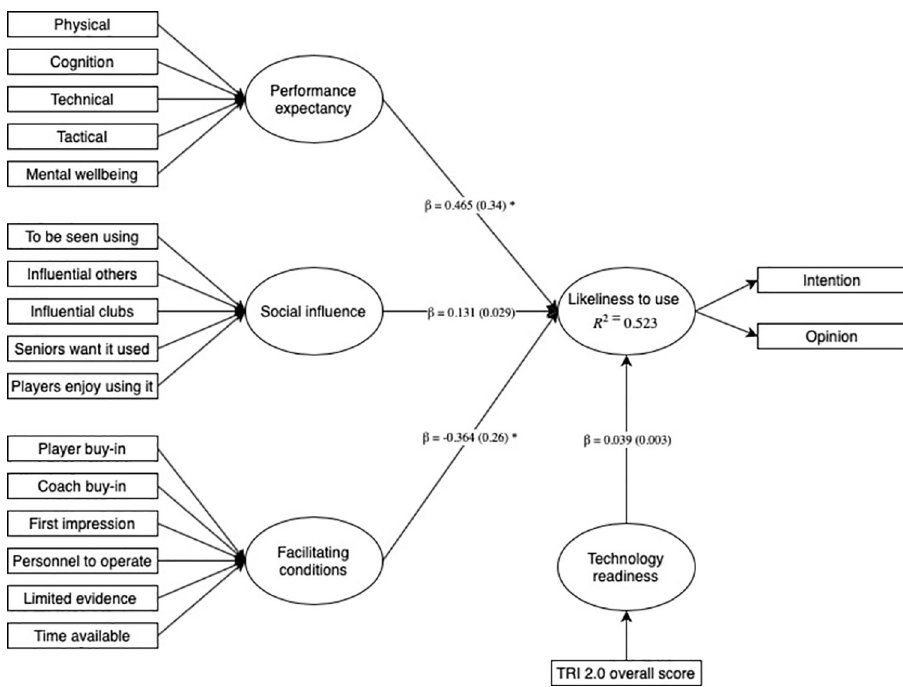
Fig 6. Node diagram showing the path coefficients between the independent construct variables and the dependent construct variables. β = beta coefficients; ( f 2 ) = path coefficient effect size; R2 = explained variance. � statistically significant at <